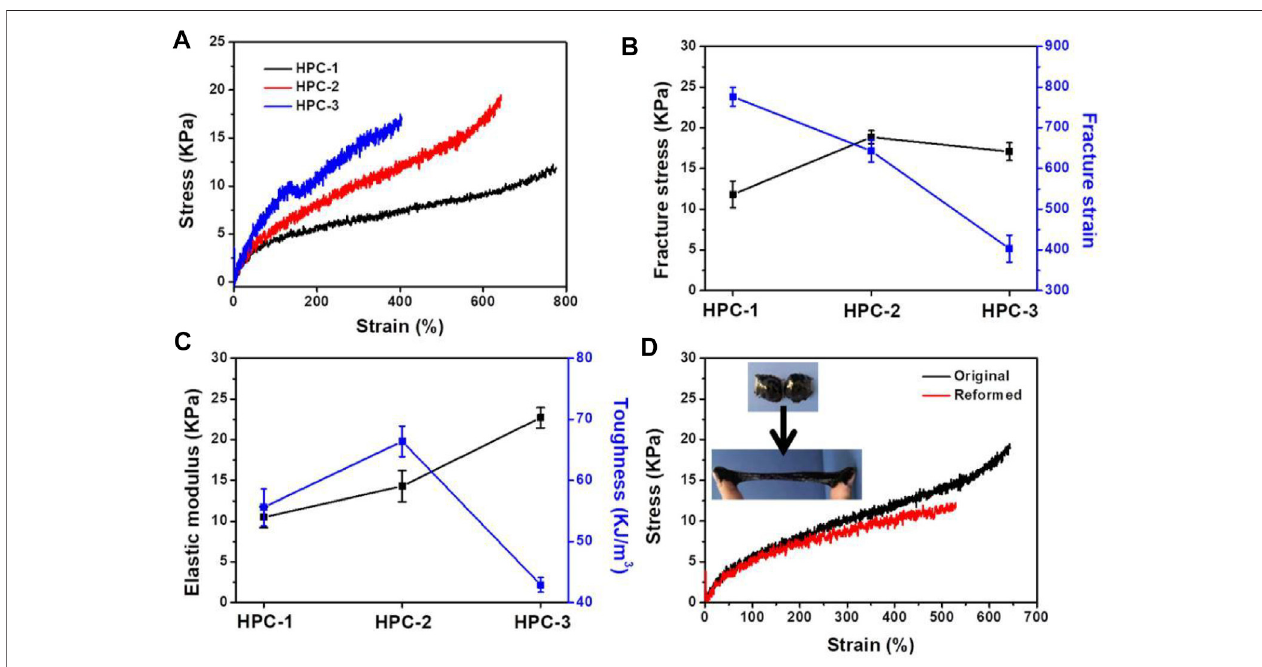
FIGURE 3 | (A) Tensile tests of the HPC hydrogels. (B) Fracture stress and strain. (C) Elastic modulus and toughness of the HPC hydrogels. (D) Tensile stress- strain curves of the integrated HPC-2 sample and the reformed